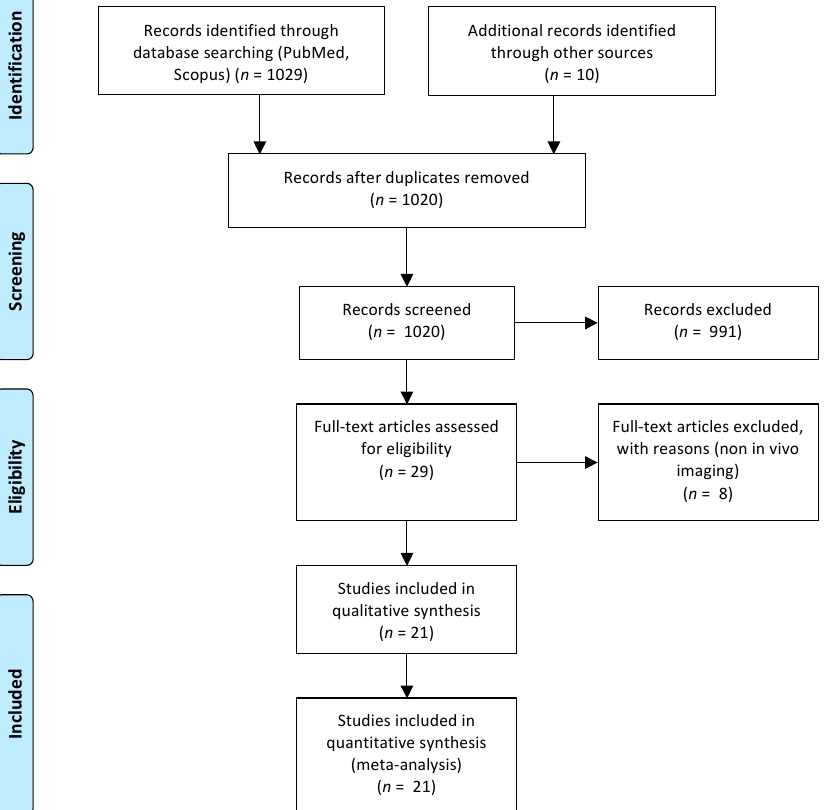
Figure 1. Preferred Reporting Items for Systematic Reviews and Meta-Analyses (PRISMA) flow chart of the literature search and selection process.